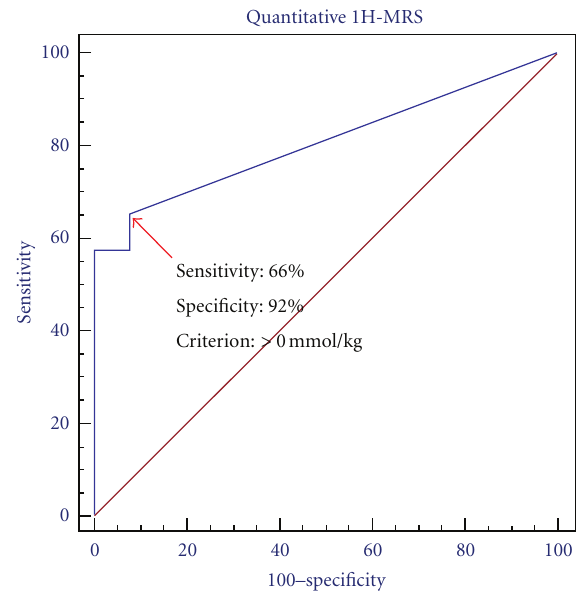
Figure 1: The ROC curve generated from the tCho concentration level measured in the 112 lesions (99 malignant and 13 benign). With a tCho cut-o ff point of > 0.0mmol/kg, the overall accuracy was 69%, with a sensitivity of 66% and a specificity of 93%.